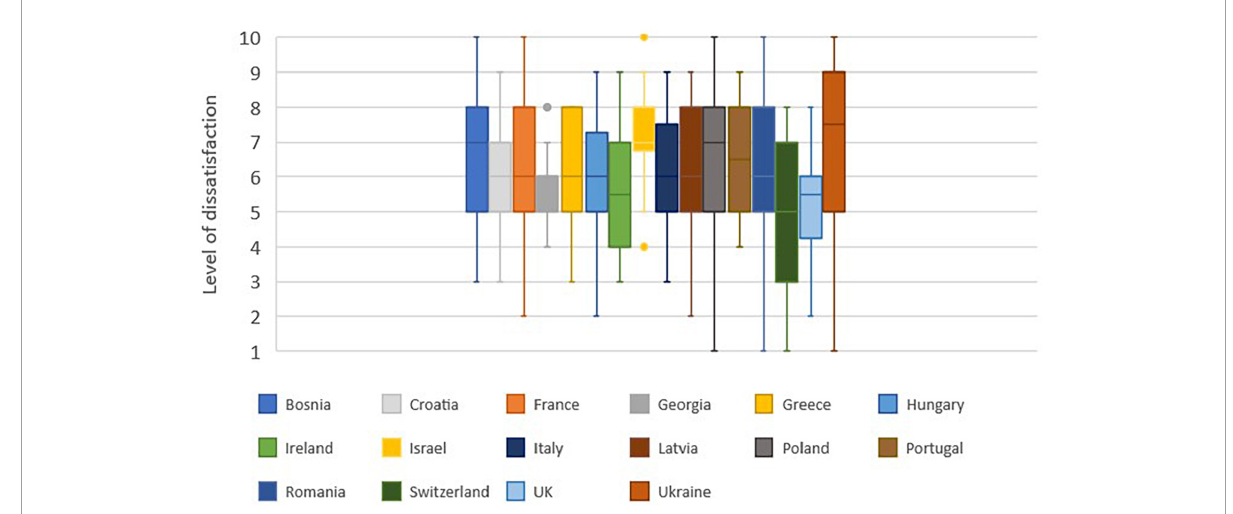
FIGURE7 Level of caregiver dissatisfaction of intermediate care. 1: happy. 10: